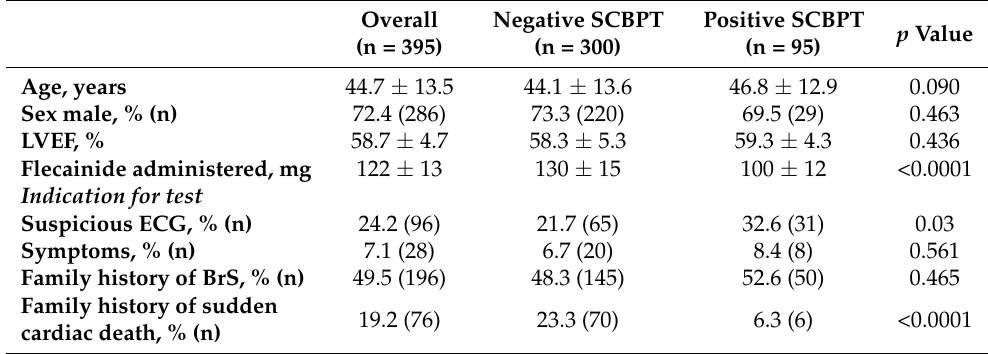
Table 1. Comparison of baseline clinical characteristics of the study population based on Brugada syndrome diagnosis after Sodium Channel Blocker Provocation Test.